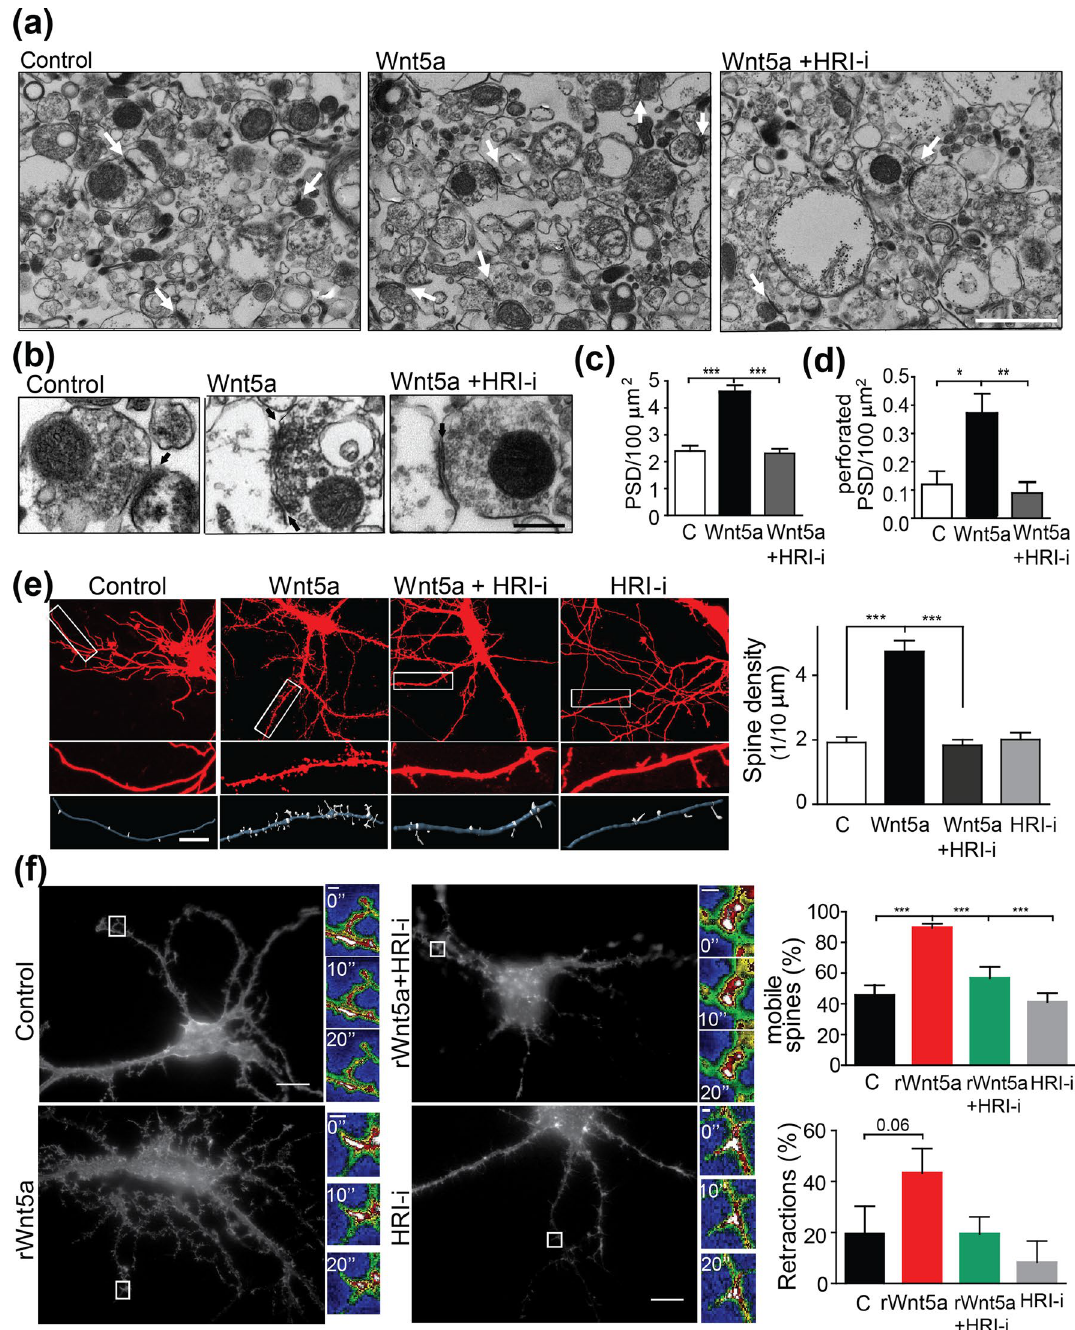
Figure 7. HRI kinase mediates Wnt5a-dependent increase in dendritic spine density. EM images of synaptosomal fractions from mouse brain. Representative images showing the number of PSDs ( a , c ) and the number of multiple synaptic contacts ( b , d ) after the treatment with control or Wnt5a conditioned medium or co-incubation withWnt5a and HRI-i. Quantifications of the synaptic contacts and number of multiple synaptic contacts per 100 µM were included. Scale bars: 1 μm and 200 nm, respectively. Bars show the mean ± SEM. N = 3 independent experiments. Control (50); Wnt5a (59); Wnt5a+ HRI-i (55) photos (* p 0.05, ** p = 0.0008, *** p = 0.0001) ( e ) EGFP-transfected mouse hippocampal neurons (DIV10) and IMARIS 3D reconstruction. Representative images of cropped neurites from hippocampal neurons treated with control or Wnt5a conditioned medium, incubated in the presence or absence of the HRI inhibitor. Quantification of the number of spines per 10 μm of neurite. Bars show the mean ± SEM. N = 5 independent experiments. Control (82); Wnt5a (129); Wnt5a+ HRI-i (86); HRI-I (105) dendrites (*** p = 0.0001). ( f ) EGFP-LifeAct-transfected hippocampal neurons in the absence (control) or presence of rWnt5a, rWnt5a+HRI-i or HRI-i alone for 1 h. Insets show the fluorescence intensity of one representative protrusion measured during the indicated time (shown in each inset, 0, 10, 20 s). The graphs show the percentage (%) of mobile protrusions and the % of retraction movement for each condition. N=3 independent experiments. Control (7); rWnt5a (12); rWnt5a+HRI-I (7); HRI-I (5), number of cells from 3 independent experiments. (* p 0.05, ** p < 0.001, (*** p =